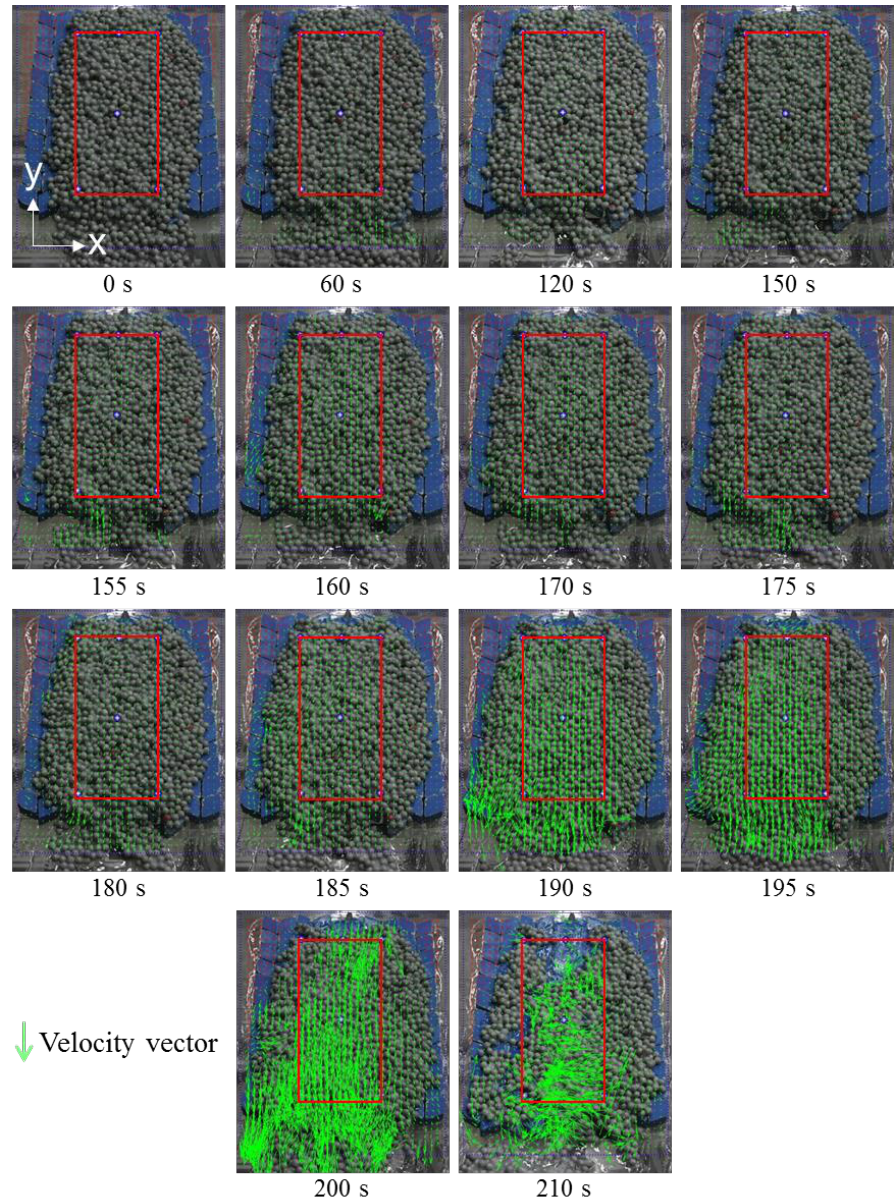
Figure 13. Velocity fields of round grinding stones at different stages.